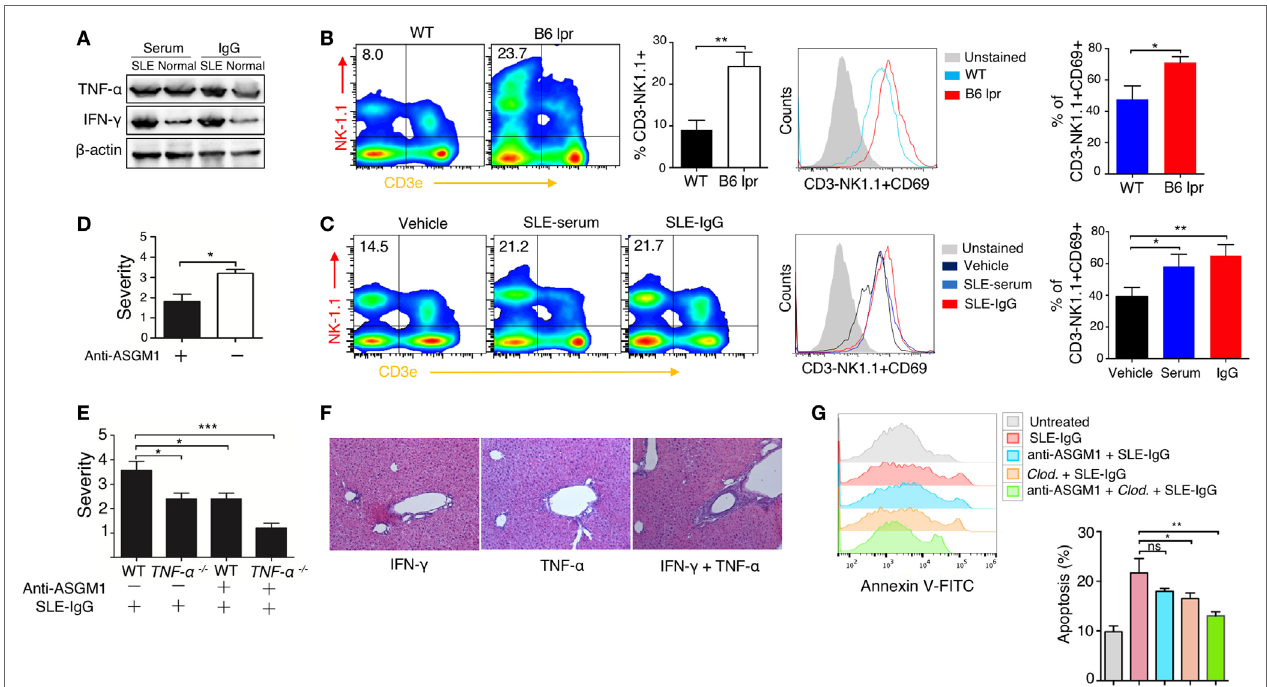
FigUre 4 | Synergistic effect of macrophage and natural killer (NK) cells on hepatic apoptosis induced by lupus immunoglobulin G (IgG). (a) Western blot showing the levels of TNF- α and IFN- γ in the liver from C57BL/6 mice with intrahepatic injection of the same dose of systemic lupus erythematosus (SLE) and normal serum, SLE, and normal IgG. (B) Flow cytometry analysis of NK cell activation in the liver from B6 lpr (25 w) and age-matched control mice using anti-NK1.1, anti-CD3e and anti CD69 antibodies. The result is representative of three independent experiments, n = 6 mice per group/experiment. (c) Flow cytometry analysis of NK cell activation in the liver from C57BL/6 mice with intrahepatic injection of SLE-serum (treated for 72 h), SLE-IgG (treated for 48 h), or phosphate-buffered saline (treated 48 h) using anti-NK1.1, anti-CD3e and anti CD69 antibodies (the result is representative of three independent experiments, n = 5 mice per group/ experiment). (D) Severity of liver inflammation 48 h after intrahepatic injection of SLE-IgG in C57BL/6 mice with or without NK depletion using anti-ASGM1 antibody treatment. * p < 0.05 (the result is representative of three independent experiments, n = 5 mice per group/experiment.) (e) Severity of liver inflammation 48 h after intrahepatic injection of SLE-IgG (200 µg) in wild type and TNF- α deficient mice with or without NK cell depletion, respectively (*** p < 0.001, * p < 0.05 the result is representative of three independent experiments, n = 5 mice per group/experiment). (F) Representative images of liver inflammation triggered by intrahepatic injection of recombined murine IFN- γ (500 ng/mouse) and/or TNF- α (200 ng/mouse) by HE staining. Original manifestation, 100 × (the result is representative of three independent experiments, n = 7 mice per group/experiment). (g) Analysis of apoptotic hepatocytes 48 h after intrahepatic injection of SLE-IgG (200 μ g/mouse) in mice with macrophage or NK cell depletion (the results are representative of three independent experiments, n = 4 mice per